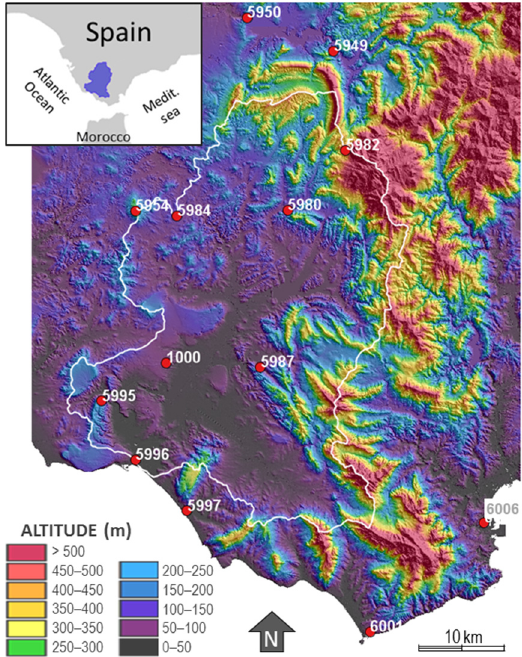
Figure 1. Map of the Barbate River basin and location of the meteorological stations considered in this study.